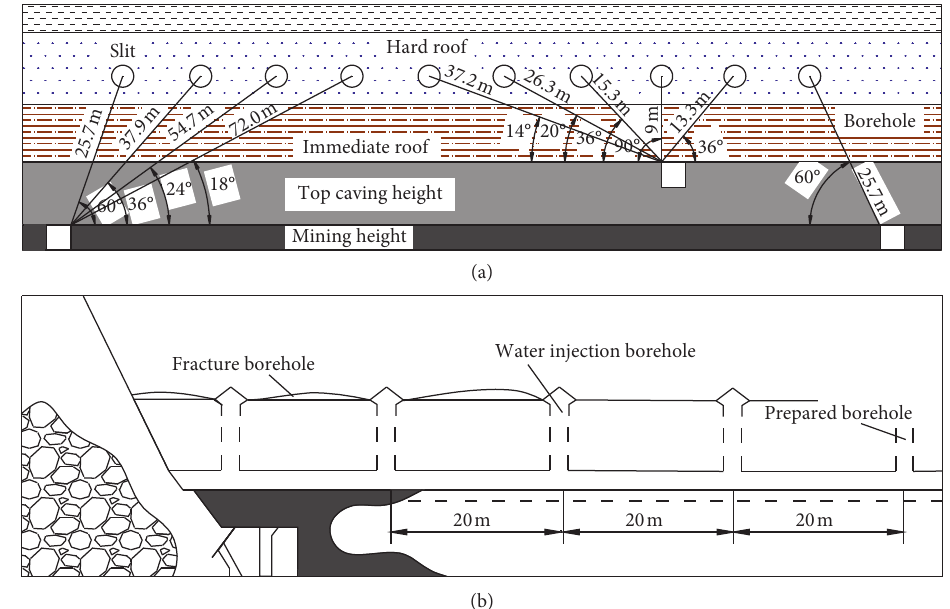
Figure 9: Layout of hydraulic cutting boreholes [27]. (a) Profile along the dip direction of the coal seam. (b) Profile along the strike of the coal seam.